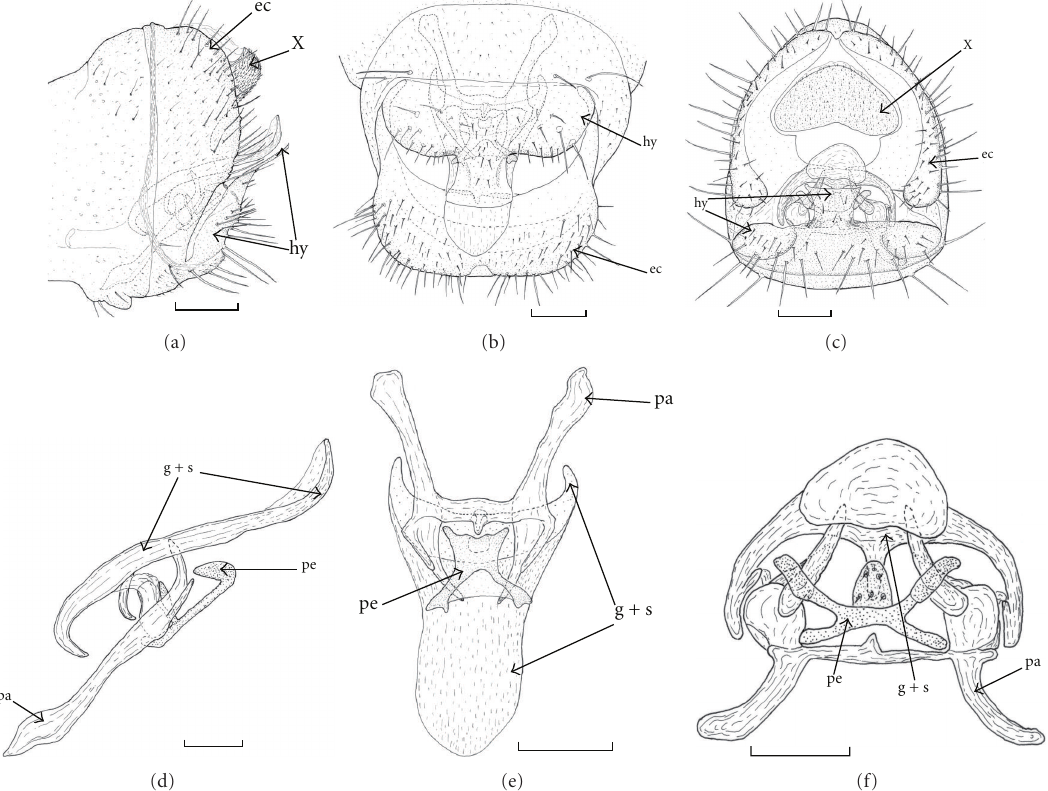
Figure 2: Incasemidalis lineatellus sp. n., male genitalia. Terminalia in lateral view (a), terminalia in ventral view (b), terminalia in caudal view (c), internal genitalia in lateral view (d), internal genitalia in ventral view (e), internal genitalia in caudal view (f). Abbreviations: ec = ectoproct, g + s = fused gonarcus + stylus, hy = hypandrium, pa = paramere, X = tenth sternite. Scale =